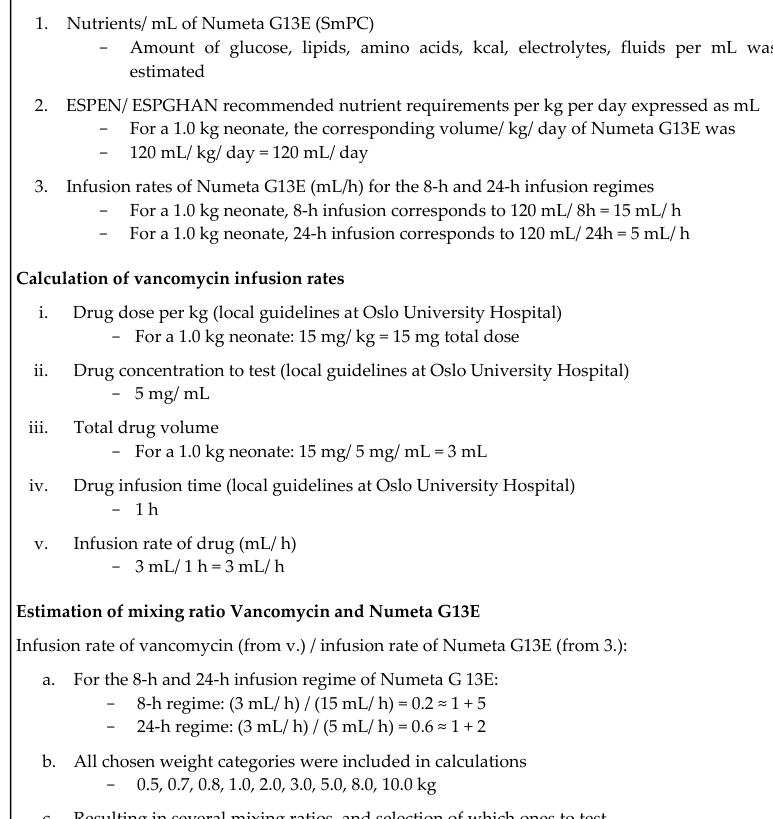
Figure 1. Example of the estimation of mixing ratios for Vancomycin and Numeta G13E. Table 4. Composition of Numeta G13E after mixing and with all additives per L [23]. aq NumetaG13E+ refers to the aqueous phase used in tests for assessment of potential precipitation. Component (amount)